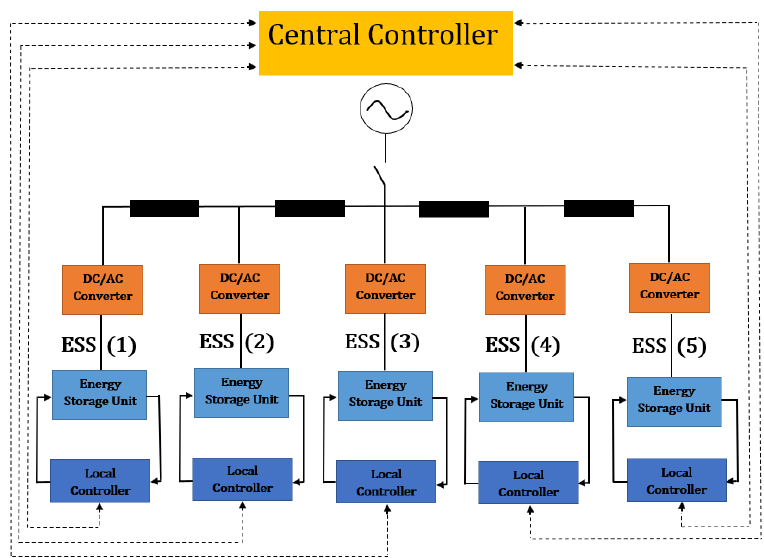
Figure 7. Centralized control of AC microgrid.